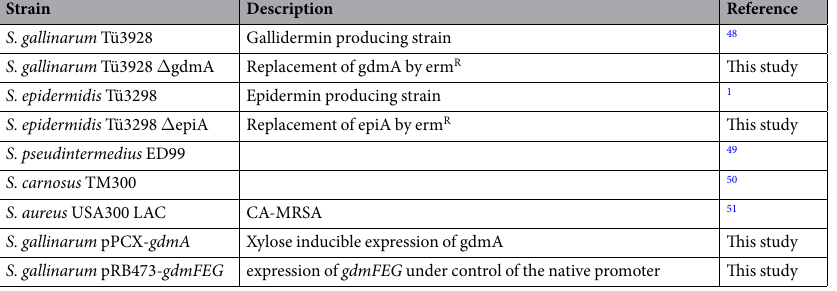
Table 1. Bacterial strains used in this